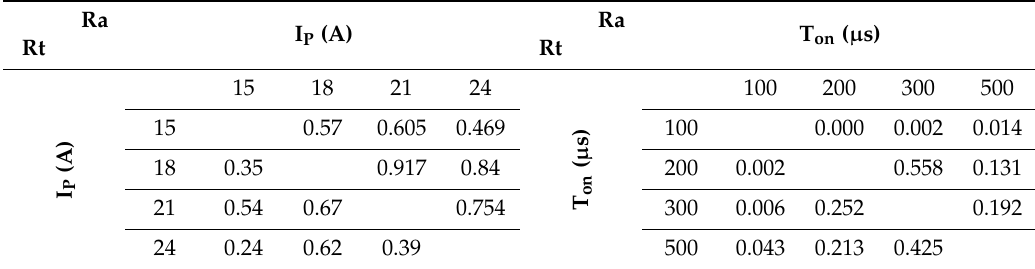
Table 3. p Values of 2-samples-t test for pulse current and pulse-on time.